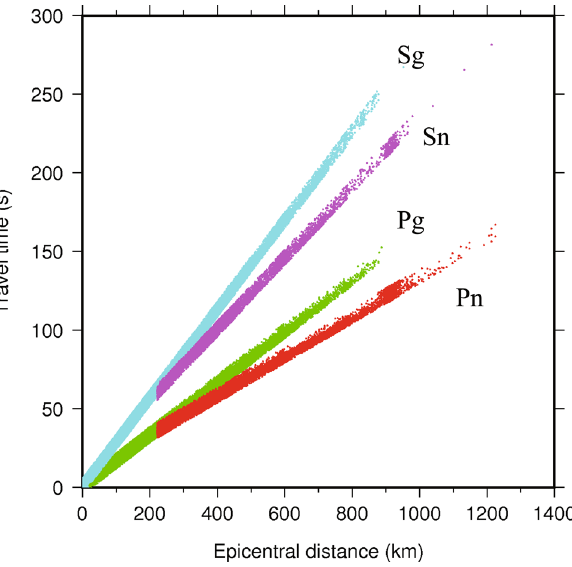
Figure 2. The distribution of travel times versus epicentral distance. The four different seismic phases are shown by different colors, with Sg (cyan), Sn (magenta), Pg (green) and Pn (red) from top to